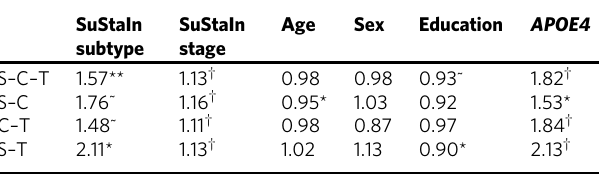
Table 3 Utility of SuStaIn subtype and stage for predicting